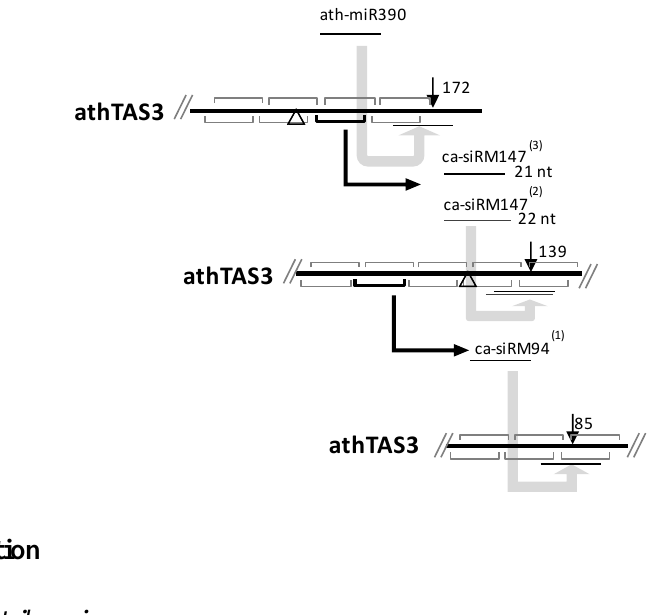
Figure 4. Cleavage cascades generated by cis -cleavages of siRNA on the sense strand of ath TAS3 . The triangle indicates the position of the nucleotide deletion in vviTAS3. The number in the bracket indicates the raw abundance of ca-siRNA in Col7d (GEO: